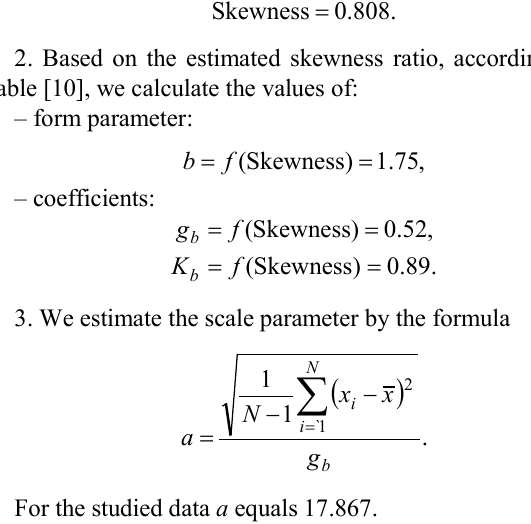
Fig. 5. Listing of the agreement verification between the theoretical lognormal distribution and the statistical one according to Pearson’s chi- square test χ 2 .